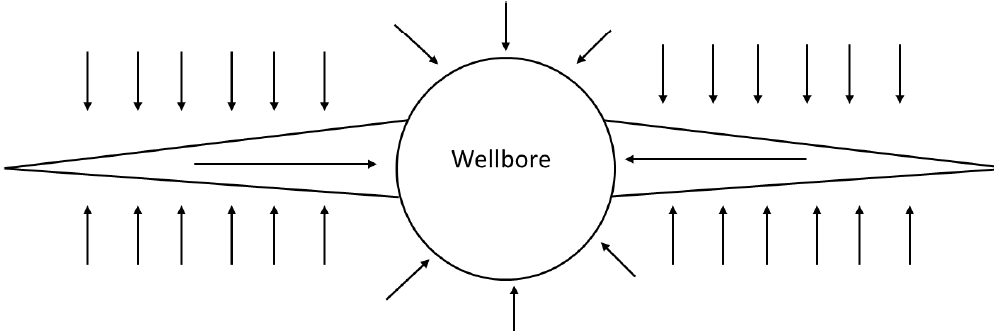
Figure 2. Hydraulic fractures and inflow of the fluid into the wellbore.